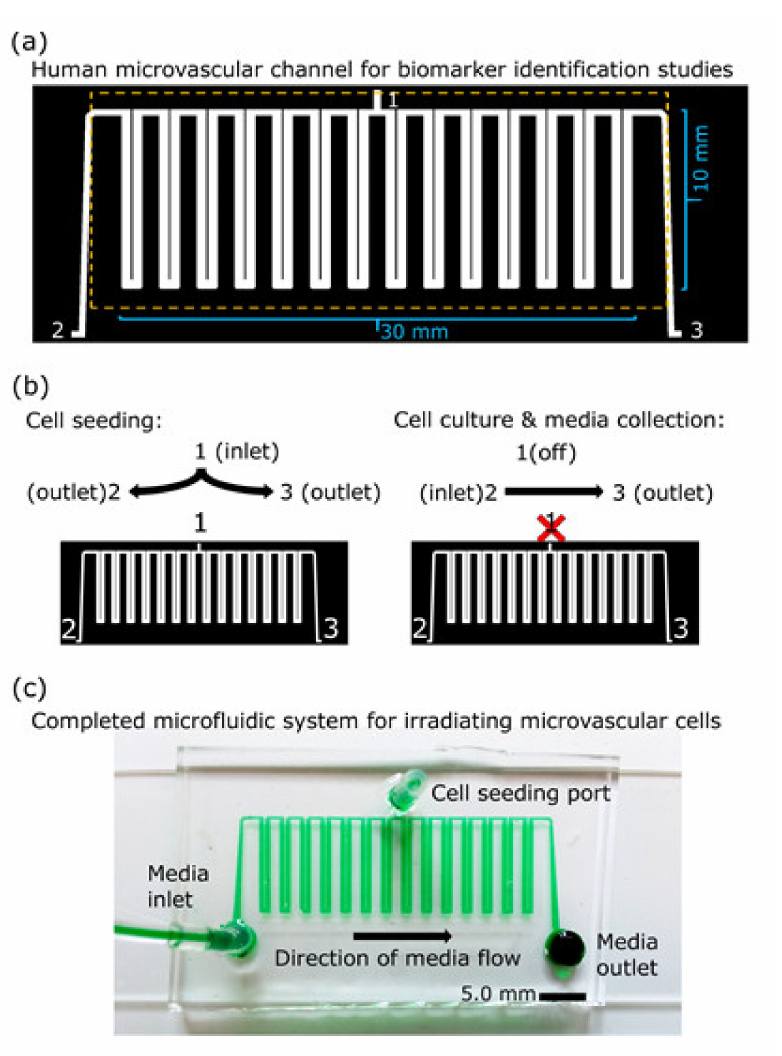
Figure 1. A large-scale microfluidic platform for generating microvascular lumens for biomarker analyses. ( a ) A schematic depicting the microfluidic platform design to maintain HMVEC-L cells and minimize dilution of analytes. The platform has three ports (1, 2, 3) that can be used for access points. Each of the 14 U-turns on the microfluidic chip contain 42 support posts (30 µ m diameter) in channel dimensions of 21 mm (l), 550 µ m (w), and 100 µ m (h), giving 1.15 µ L per U-turn; 14 U-turns and 15 interconnects (0.045 µ L each) with a single inlet and outlet channel yields a total lumen volume of approximately 17 µ L. Scale marks are shown (10 mm and 30 mm). ( b ) Diagrams for infusion flow direction for cell seeding and for culture maintenance are shown. Bilateral flow from center to end promotes uniform cell seeding throughout the long channel. During culture maintenance, the cell seeding port is sealed, and end-to-end perfusion flow maintains cell growth to achieve confluence of microvascular cells. ( c ) Image of a fabricated dye-filled microfluidic